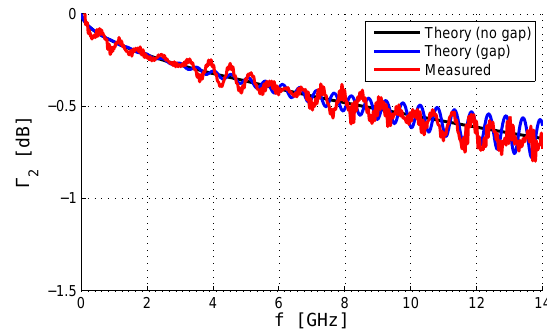
Figure 6. Input reflection coefficient of the coaxial